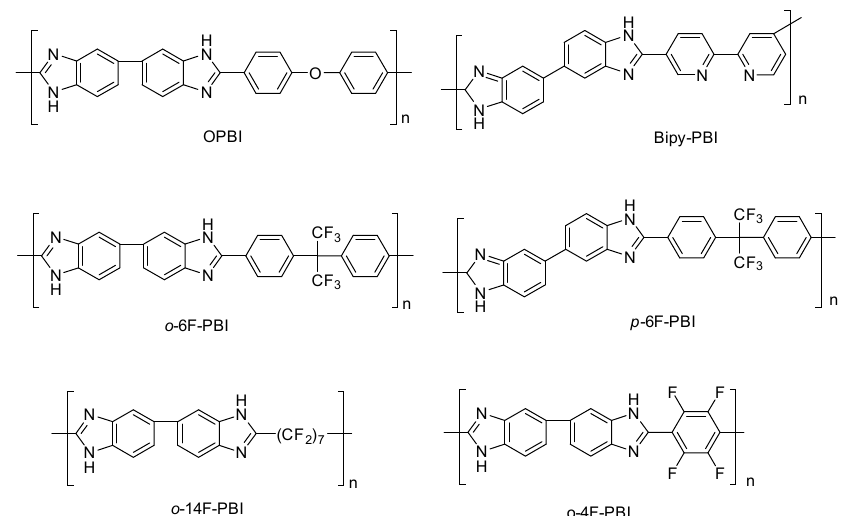
Figure 9. Di ff erent structures of PBIs. Figure 9. Different structures of PBIs.